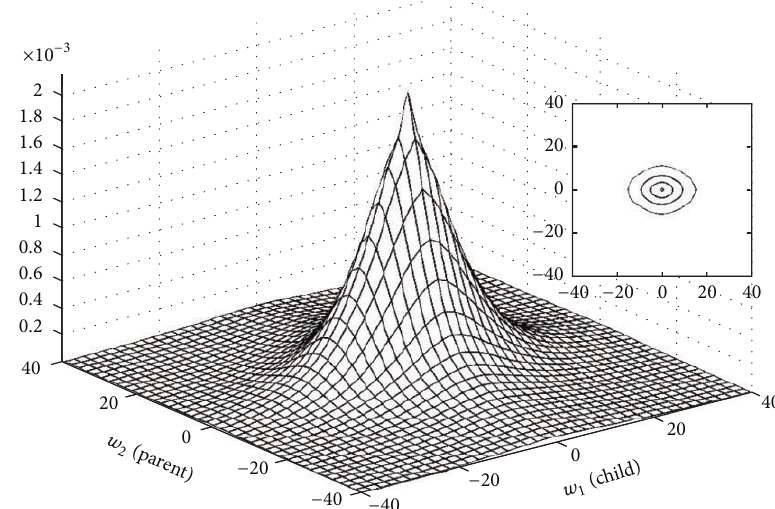
Figure 3: Empirical joint parent-child histogram of wavelet coefficients (computed from the Corel image database) [42].